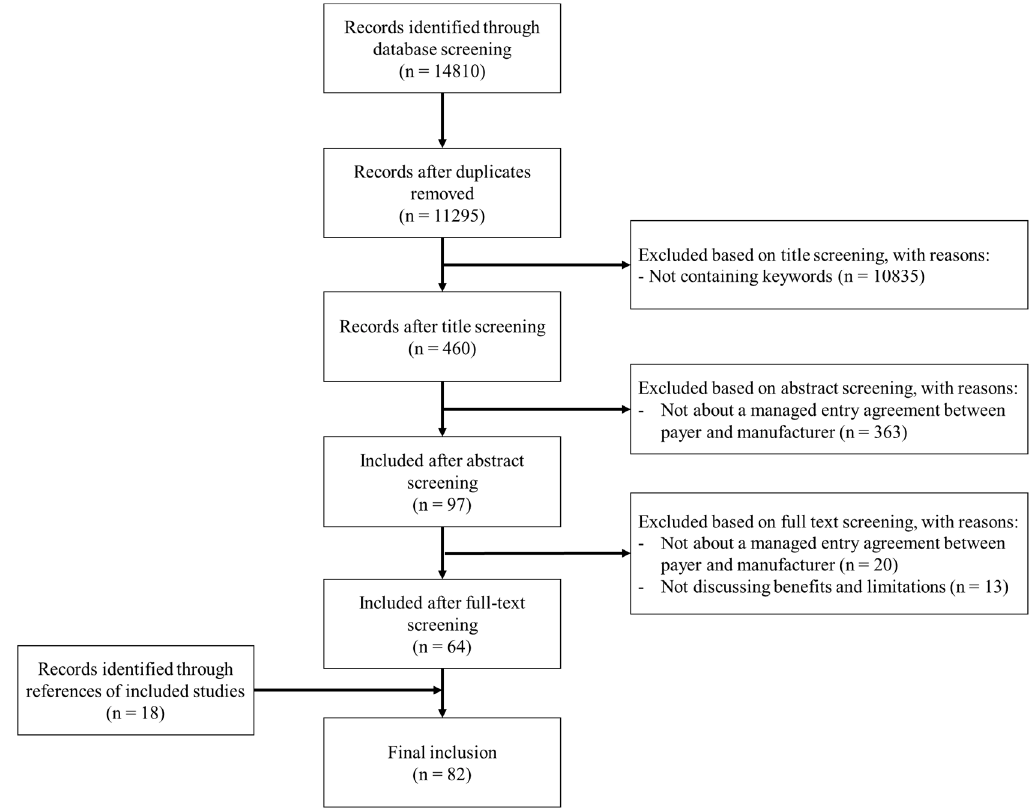
Figure A1. Flowchart for the inclusion of studies that described managed entry agreements.